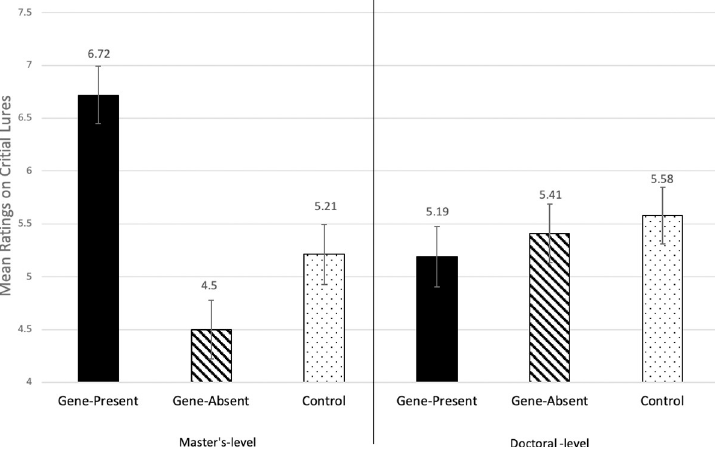
Fig 2. Critical lure scores, by condition, among master’s-level and doctoral-level clinicians in Experiment 3. Higher numbers indicate greater confidence that the critical lures were present in the target vignette. Error bars reflect one standard